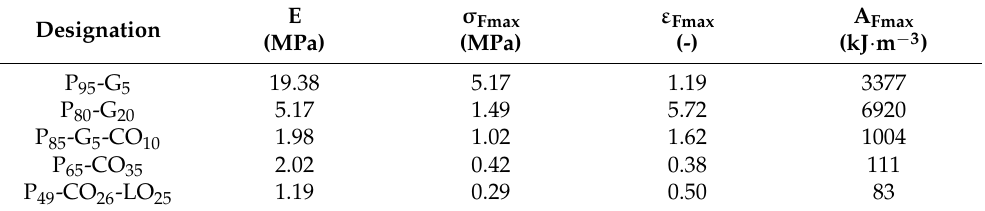
* Reprinted by permission from Springer Nature Customer Service Centre GmbH: Springer Nature, SN Applied Sciences, A new approach to the structure-properties relationship evaluation for porous polymer composites,